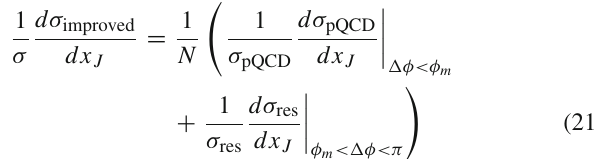
culationswhichevaluates2-to-3subprocessescorrespondsto (cid:2)φ distributions at leading-order(LO) shown in the